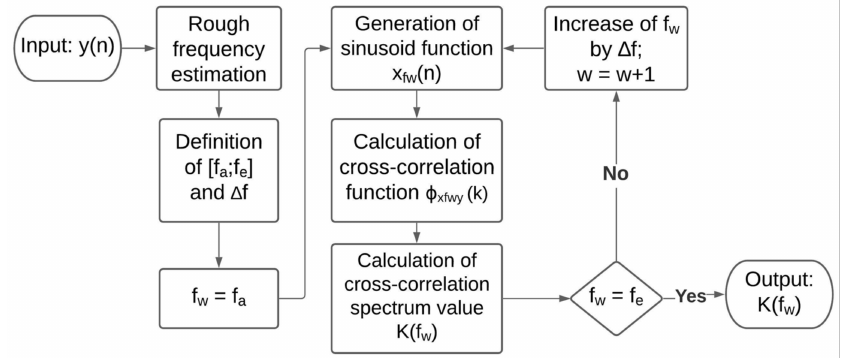
Figure 1. Calculation process of cross-correlation